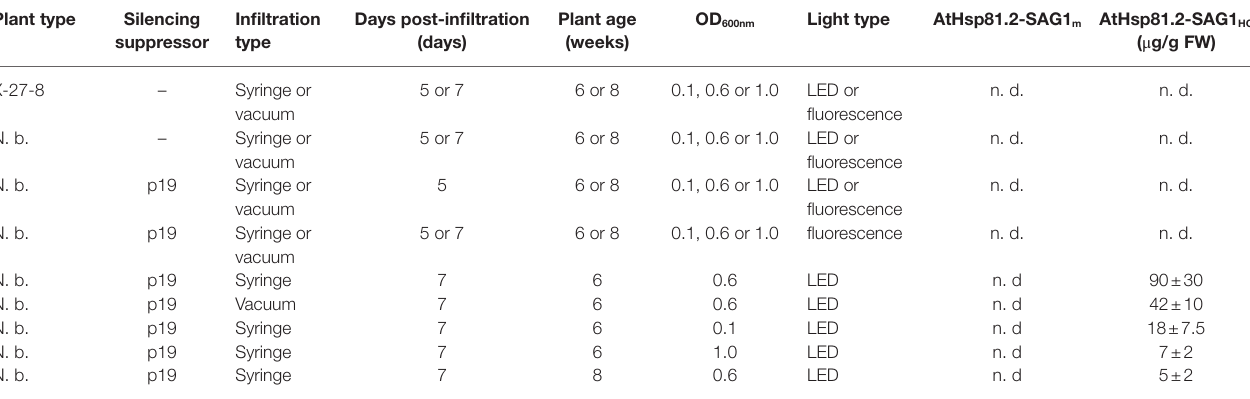
TABLE 1 | Parameters evaluated to optimize the transient expression of AtHsp81.2-SAG1 HC and AtHsp81.2-SAG1 m proteins in X-27-8 transgenic N. tabacum and N. benthamiana . Plant type Silencing